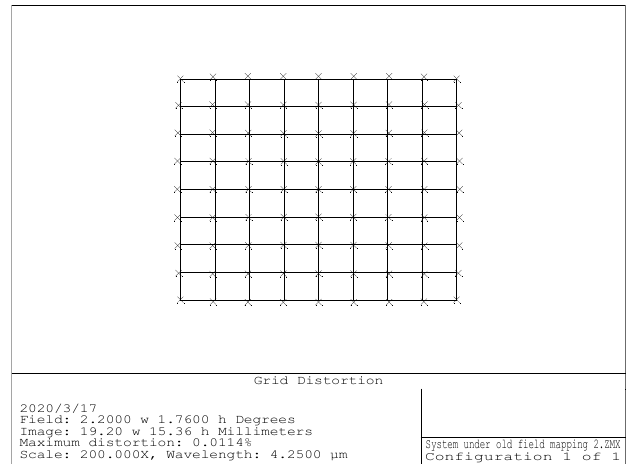
Figure 11. Grid distortion. The X point is the actual field point, and the grid is the theoretical field point. In order to visually display the distortion characteristics, the distortion deviation is enlarged by 200 times.